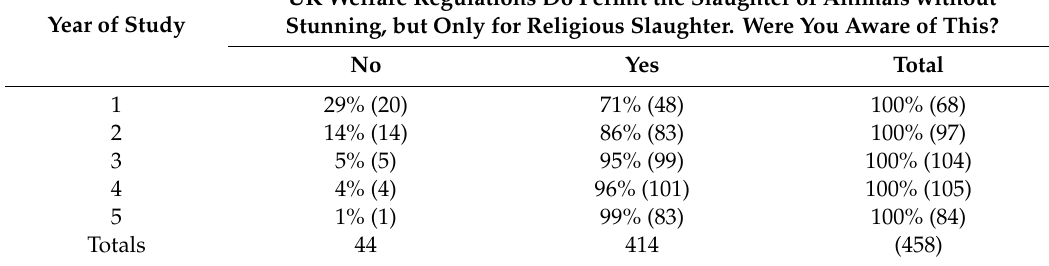
Table 1. Cross tabulation of the year of study of respondent and awareness that slaughter without stunning for religious purposes was permissible in the